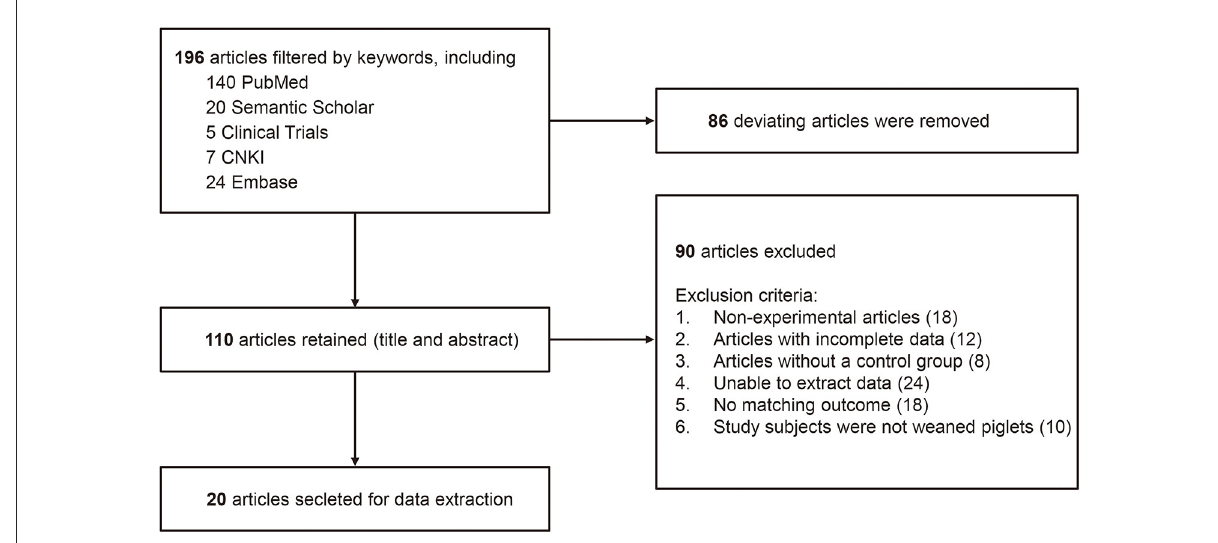
FIGURE1 A flow diagram of studies included in the meta-analysis Lactobacillus -based probiotics for growth performance and intestinal physiology in piglets.